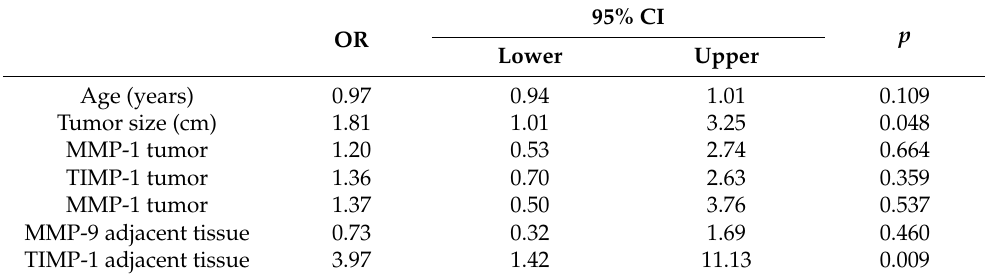
Table 3. Multivariate prediction of belonging to the invasive tumor group: binary logistic